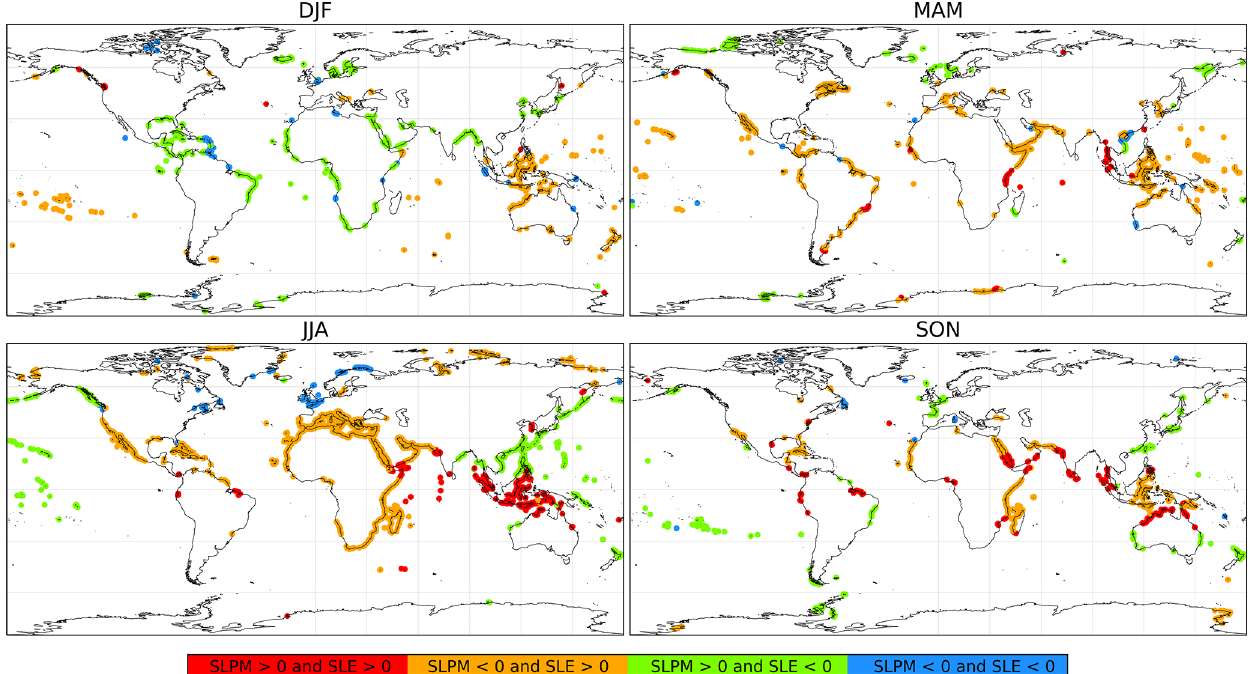
Figure 6. Same as Fig. 5 but regarding agreement and disagreement in the sign of anomalies (LIG minus PI) in sea level pressure min- ima (SLPM) and sea level extremes